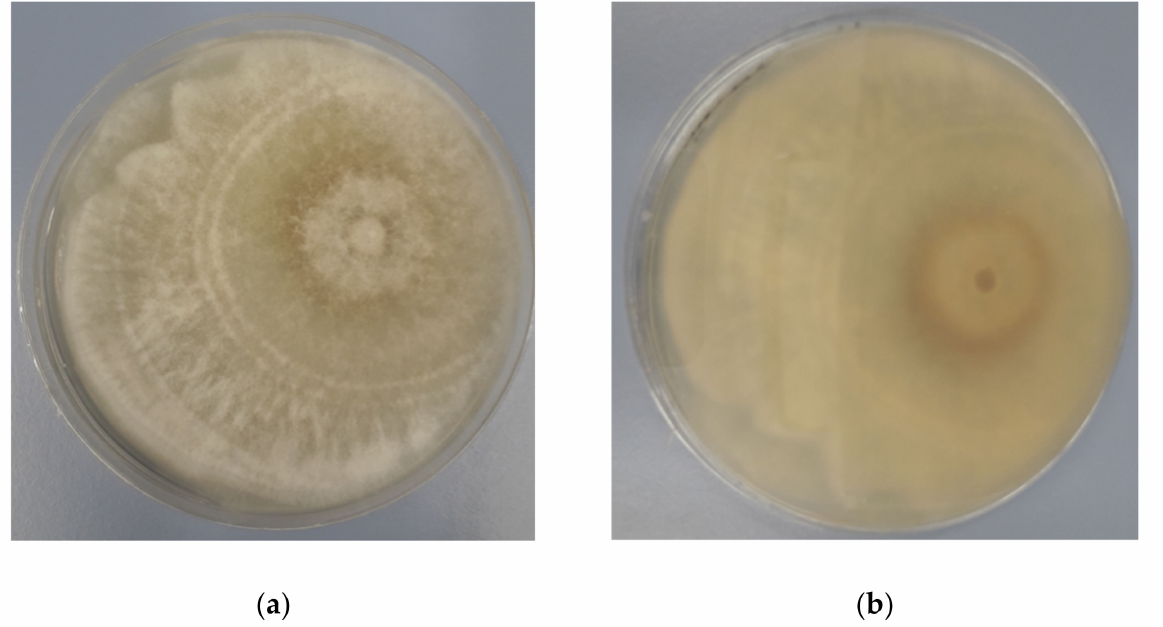
Figure 1. Fourteen-day-old culture of endophytic Diaporthe on PDA ( a ) avers; ( b ) reverse (photo by B. Abramczyk).